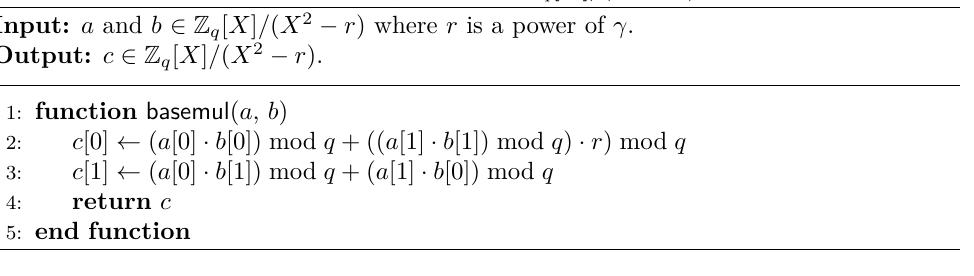
Algorithm 13 Multiplication of polynomials in Z q [ X ] / ( X 2 − r ) for Kyber